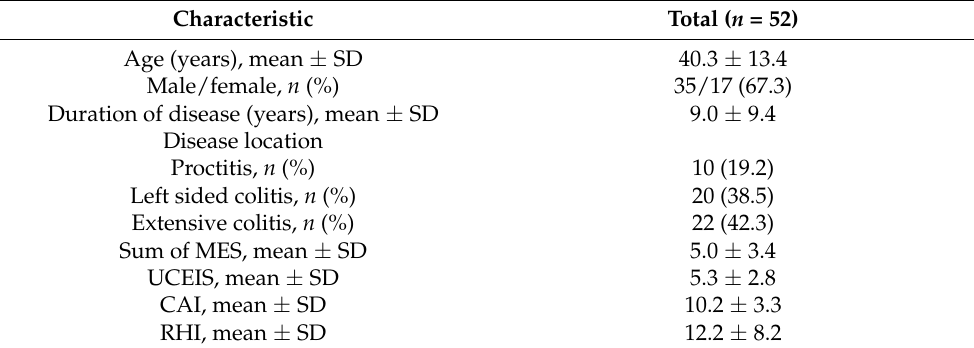
Table 1. Characteristics of patients with ulcerative colitis during sample collection.